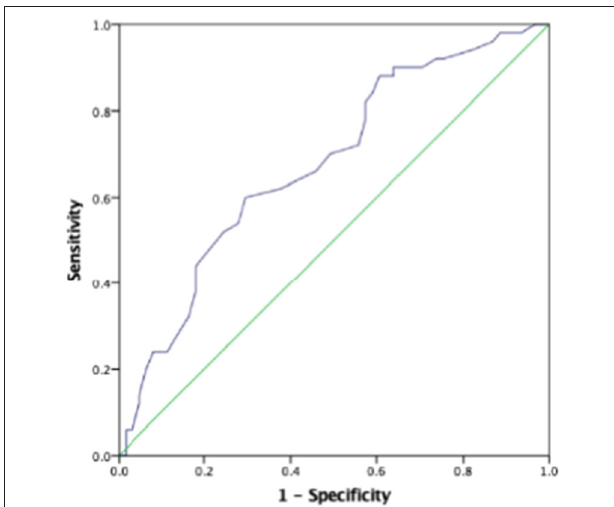
FIGURE 2 | The role of prenatal first SBP in predicting severe preeclampsia. The ROC curve illustrates prenatal first SBP. AUCs are 0.727 (95% CI 0.673–0.781, p < 0.001) for the prenatal first SBP. A cut-off valuable of 123.0 mmHg yielded good sensitivity and specificity. The sensitivity and specificity are 88.9 and 52.6%,